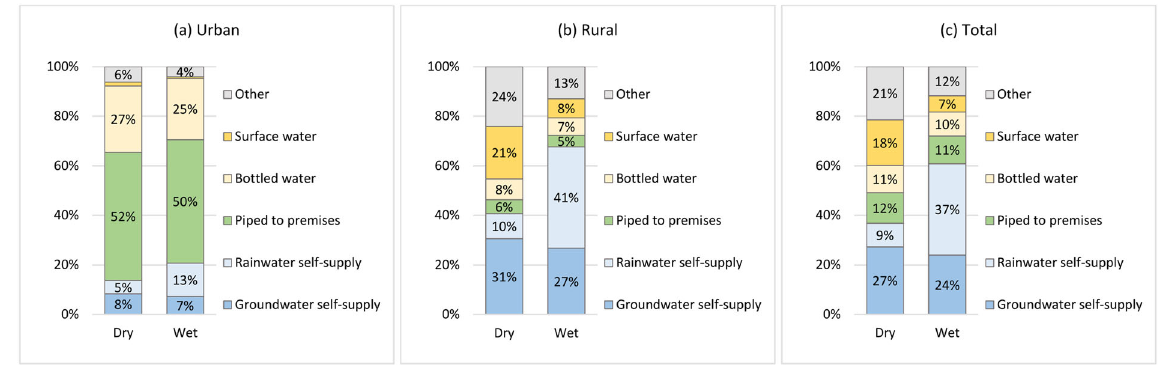
Fig. 4 Proportion of population using self-supply as a main drinking water source by season in Cambodia, 2014. In Cambodia, wet season coincides with an increase in the use of self-supply. In 2014, this seasonal shift in self-supply use was evident in a urban areas (20% in wet season vs 13% in dry season), b in rural areas (68% in wet season vs 41% in dry season), and c overall (61% in wet season vs 36% in dry season). ‘ Other ’ sources comprise public borehole/tubewells, public protected wells, public unprotected wells, tanker truck and cart with small tank.